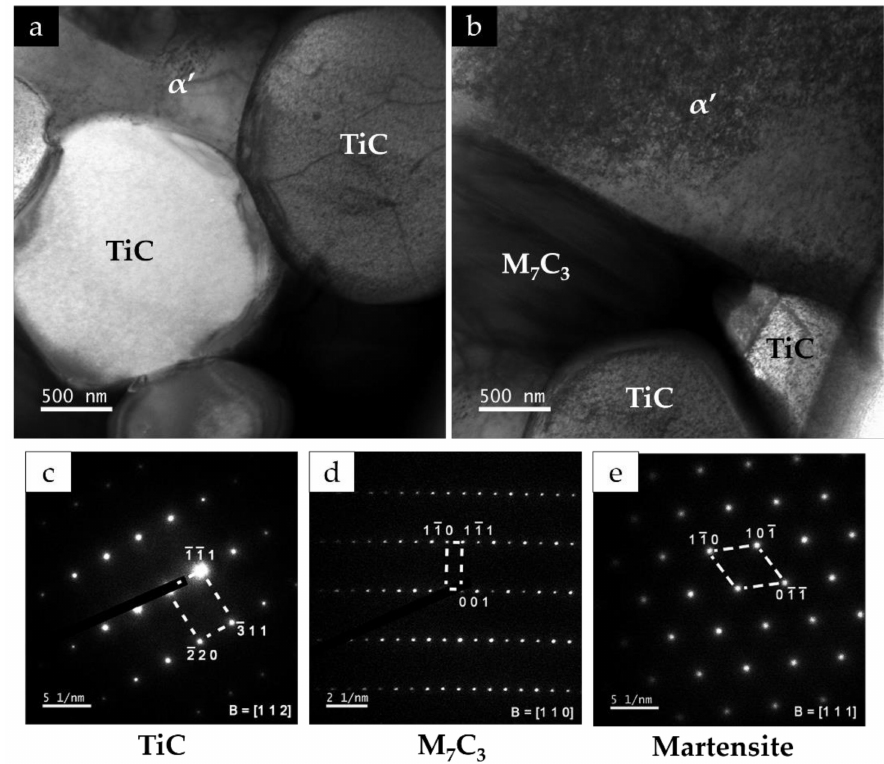
Figure 15. Dark-field TEM image of the composite showing ( a ) TiC particles and α ’ phase and ( b ) interface between α ’ and a M 7 C 3 type carbide. The identification of phases was conducted by selected area electron di ff raction (SAED) analysis with ( c ) [1 1 2] zone axis of TiC, ( d ) [1 1 0] zone axis of M 7 C 3 , and ( e ) [1 1 1] zone axis of α ’.